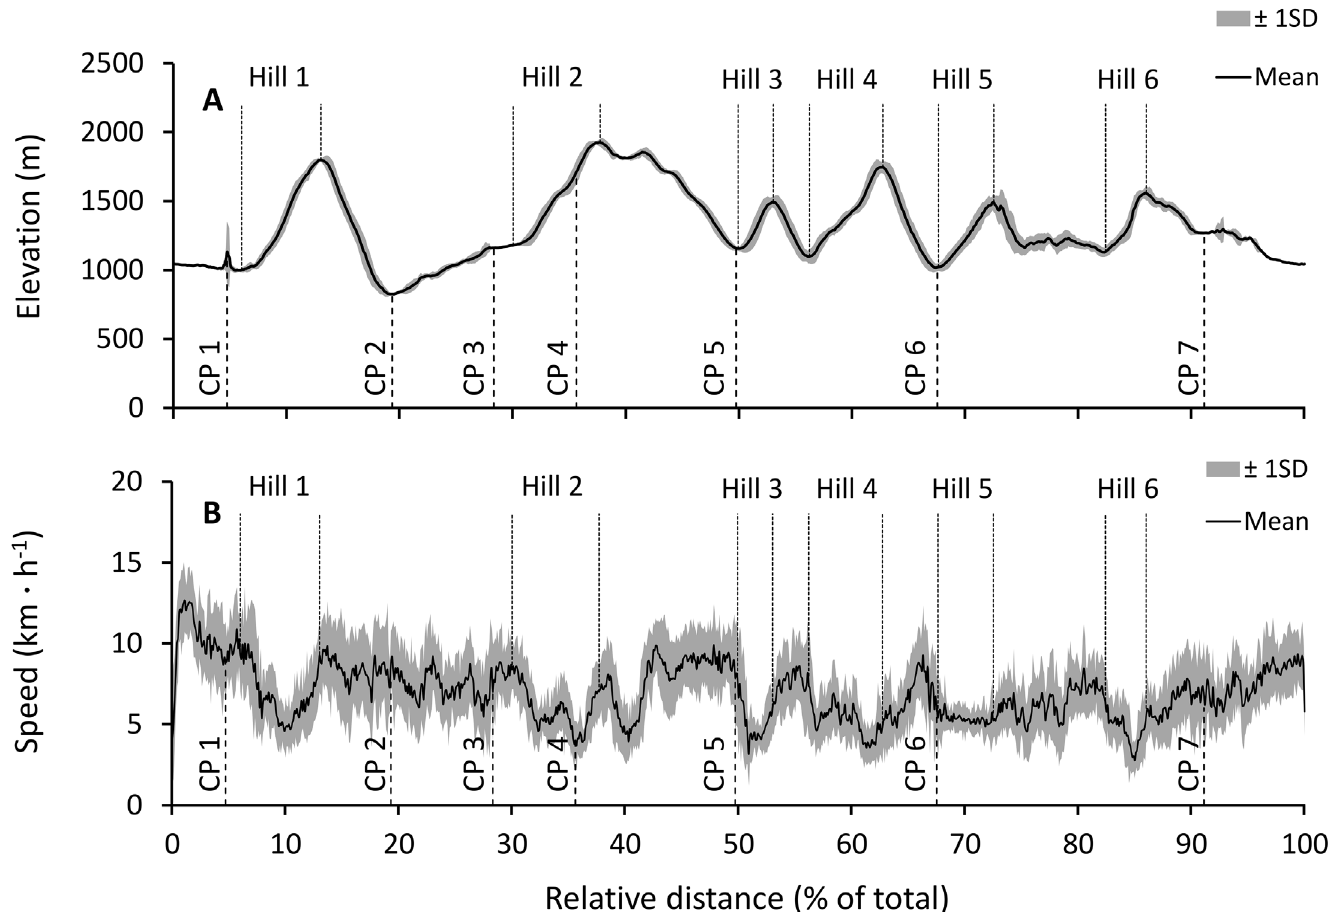
Fig 2. UTMB course outline and elevation profile. (A) Mean ( ± SD) group elevation data from the Digital Elevation Model values associated with measures of geographical positions, and (B) group speed data associated with measures of geographical positions (CP, refer to legend of Fig 1 for